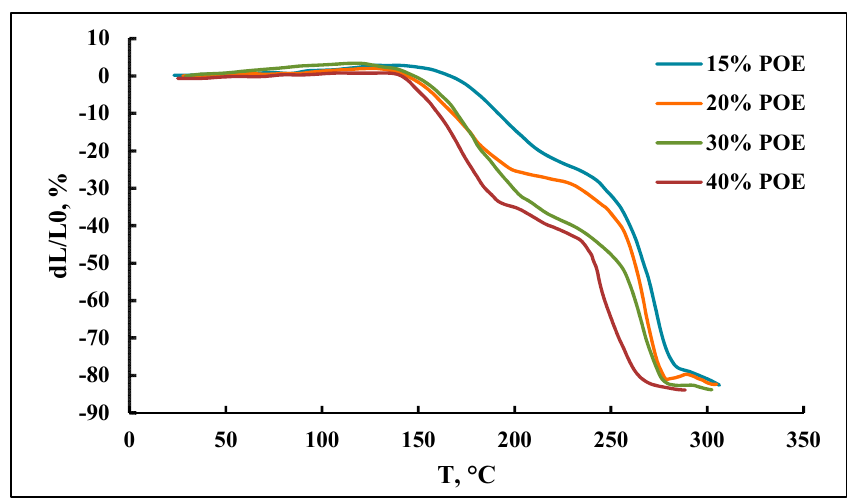
Figure 5. The curves of thermomechanical analysis of polymers.